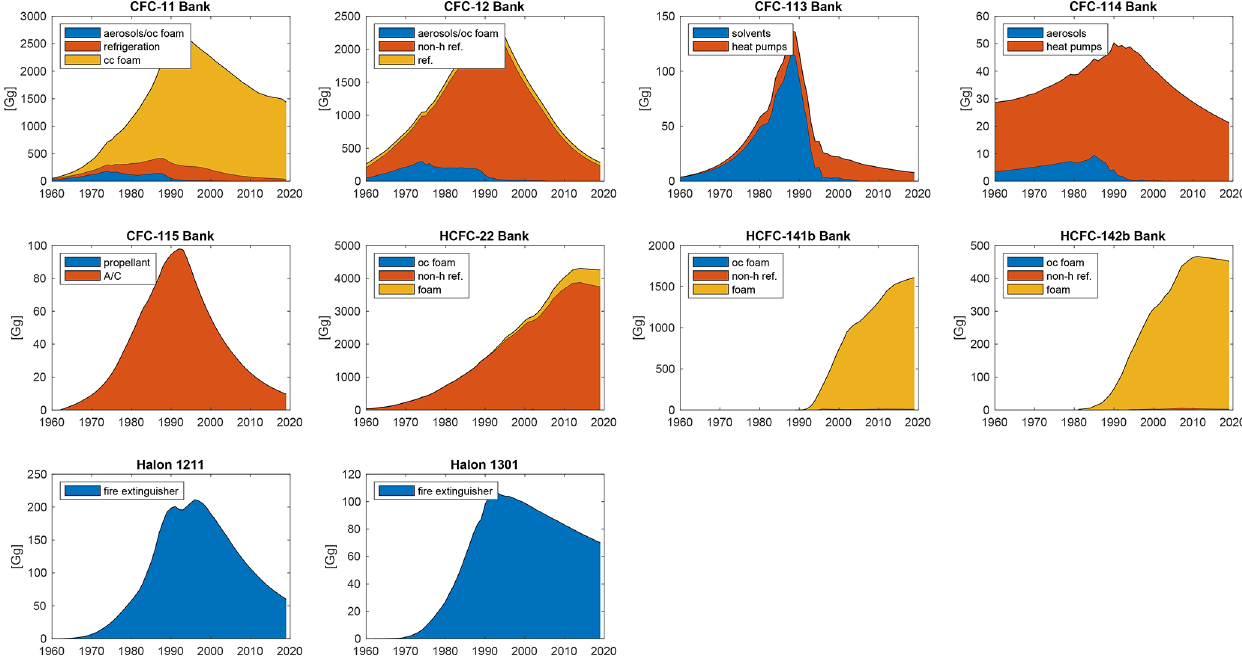
Figure 6. Bank size by equipment type. Bank estimates reported in the above figures are the median estimates from the Bayesian analysis. In the above legends, “cc” refers to closed-cell foams, “non-h ref.” refers to non-hermetic refrigeration, “ref.” refers to refrigeration, and “A/C” refers to air